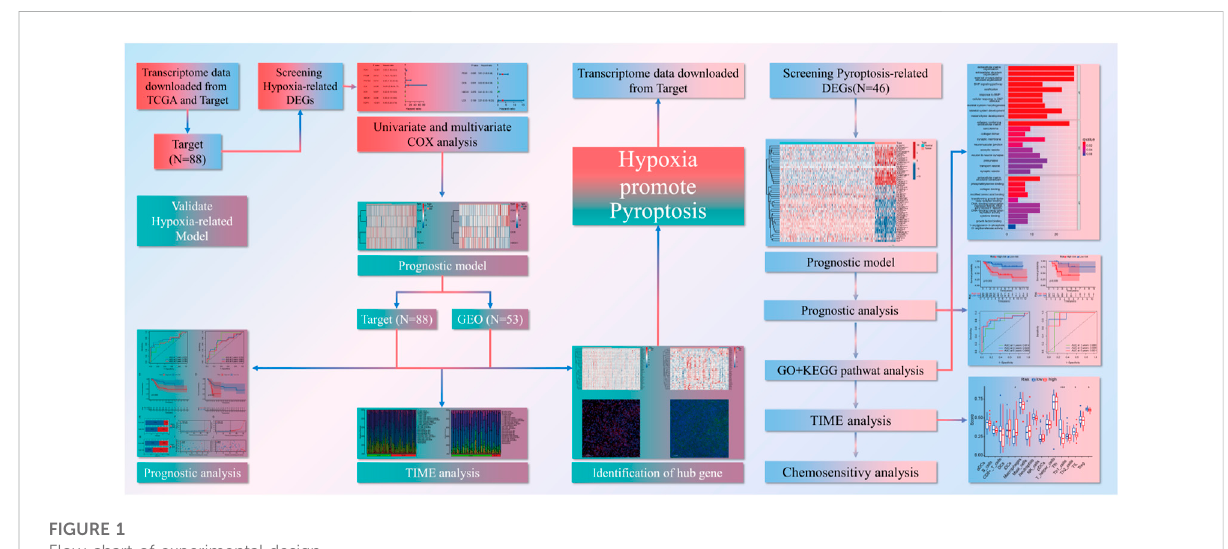
FIGURE 1 Flow chart of experimental